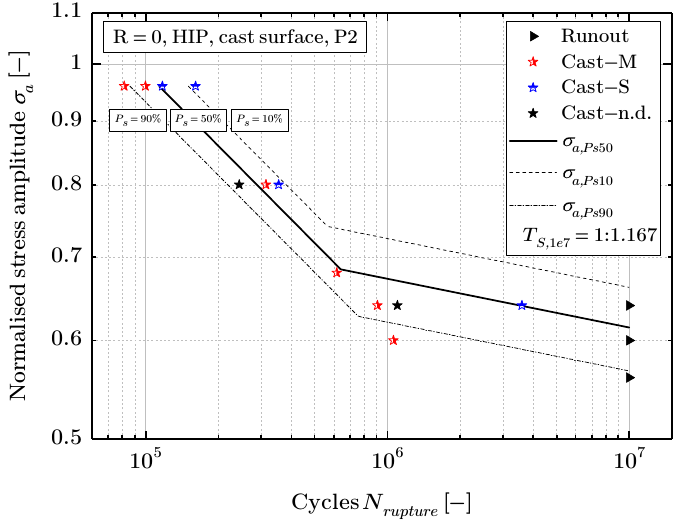
Figure 3. Normalised S/N-curve of the specimen series HIP